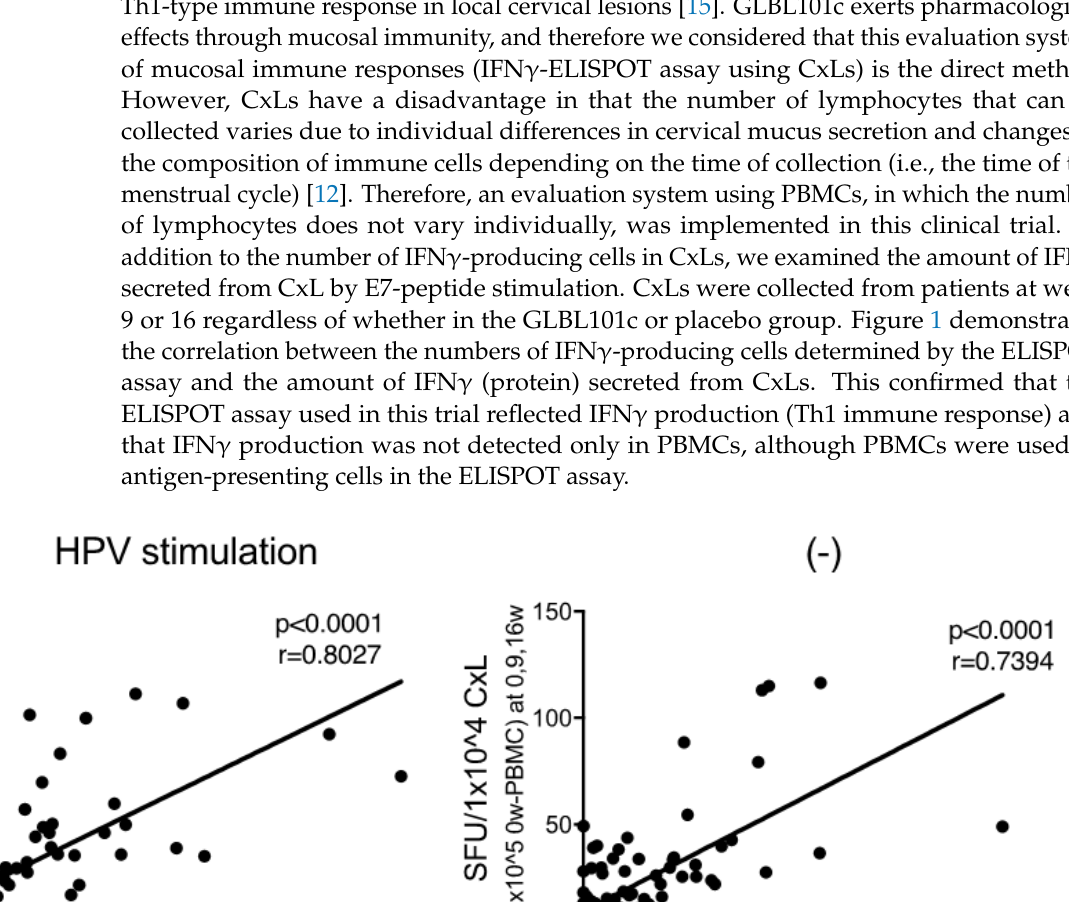
Figure 2. Time-dependent increases in the number of IFN γ -producing cells in the GLBL101c group. The number of IFN γ - producing cells at pre-immune (0 week), 9week, and 16week was compared for CxL and PBMC with (red dot) and without (circle dot) E7 stimulation. The number of spots with E7 stimulation (HPV+) tended to increase in a time-dependent man- ner, with three samples showing a similar increase.